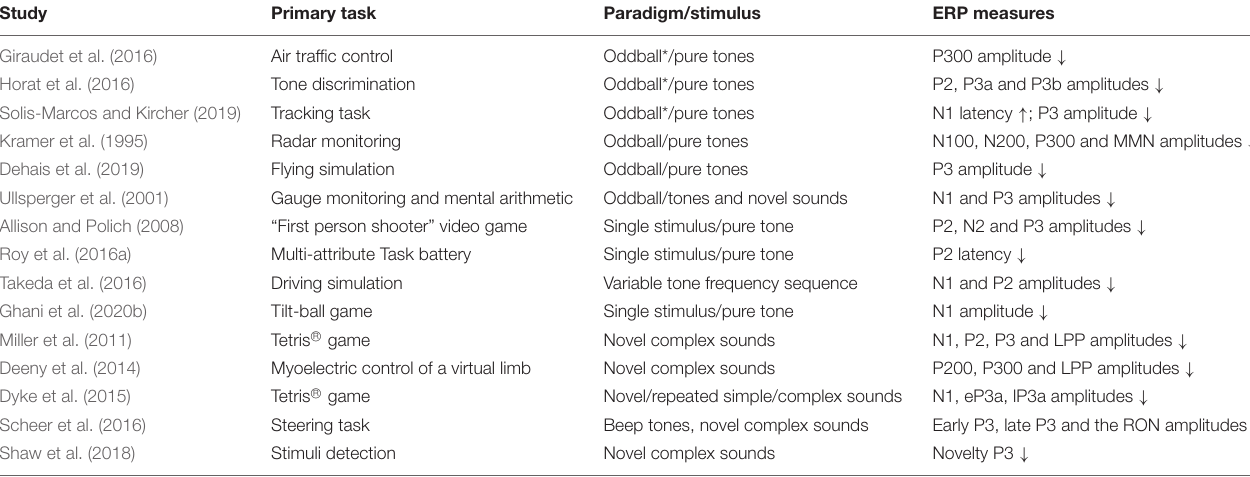
TABLE 1 | Overview of the previous typical tir-aERP-based mental workload (MWL)